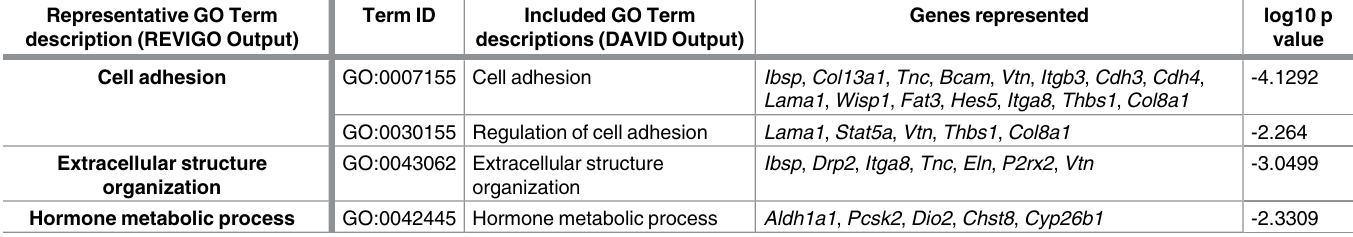
Table 7. Biological processes(BP) GO terms significantly represented in the list of DEG between P1 and P6 Lfng-GFP +